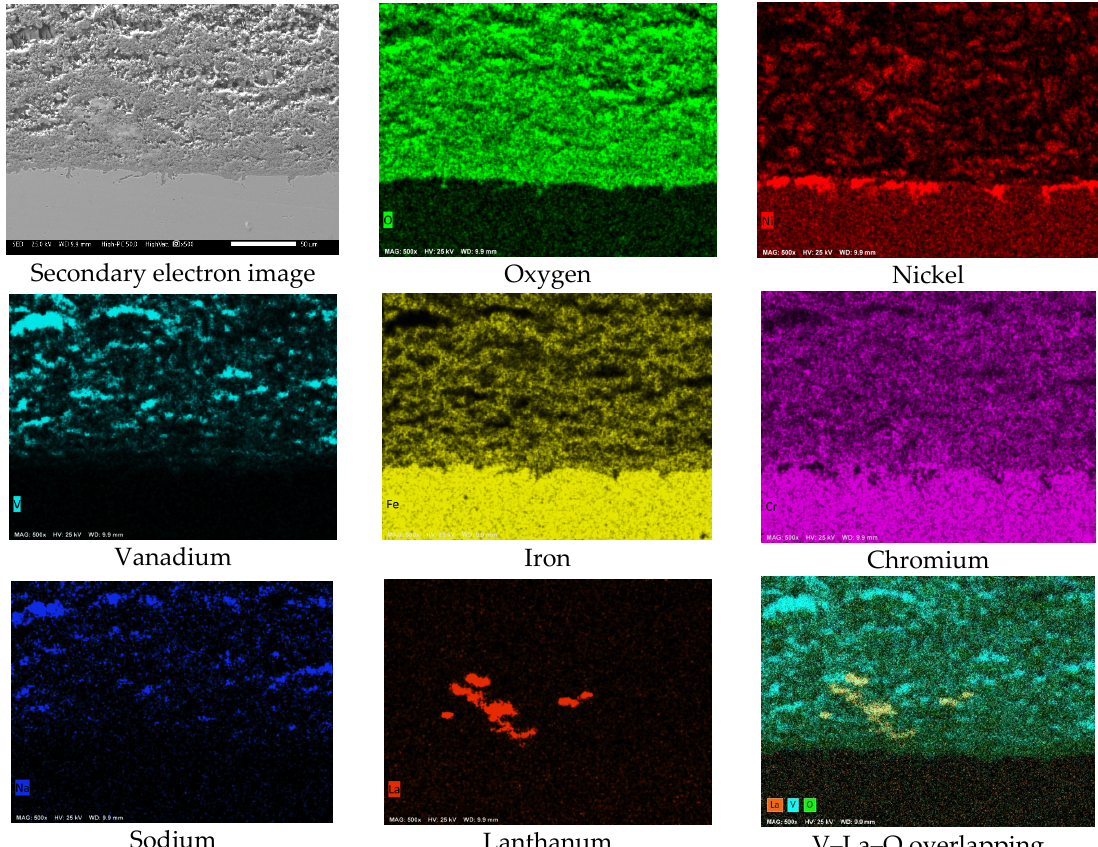
Figure 11. Cross-sectional aspect and element mapping of the 304H steel interface corroded in NaVO 3 with 10% La 2 O 3 at 900 °C after 100 h.